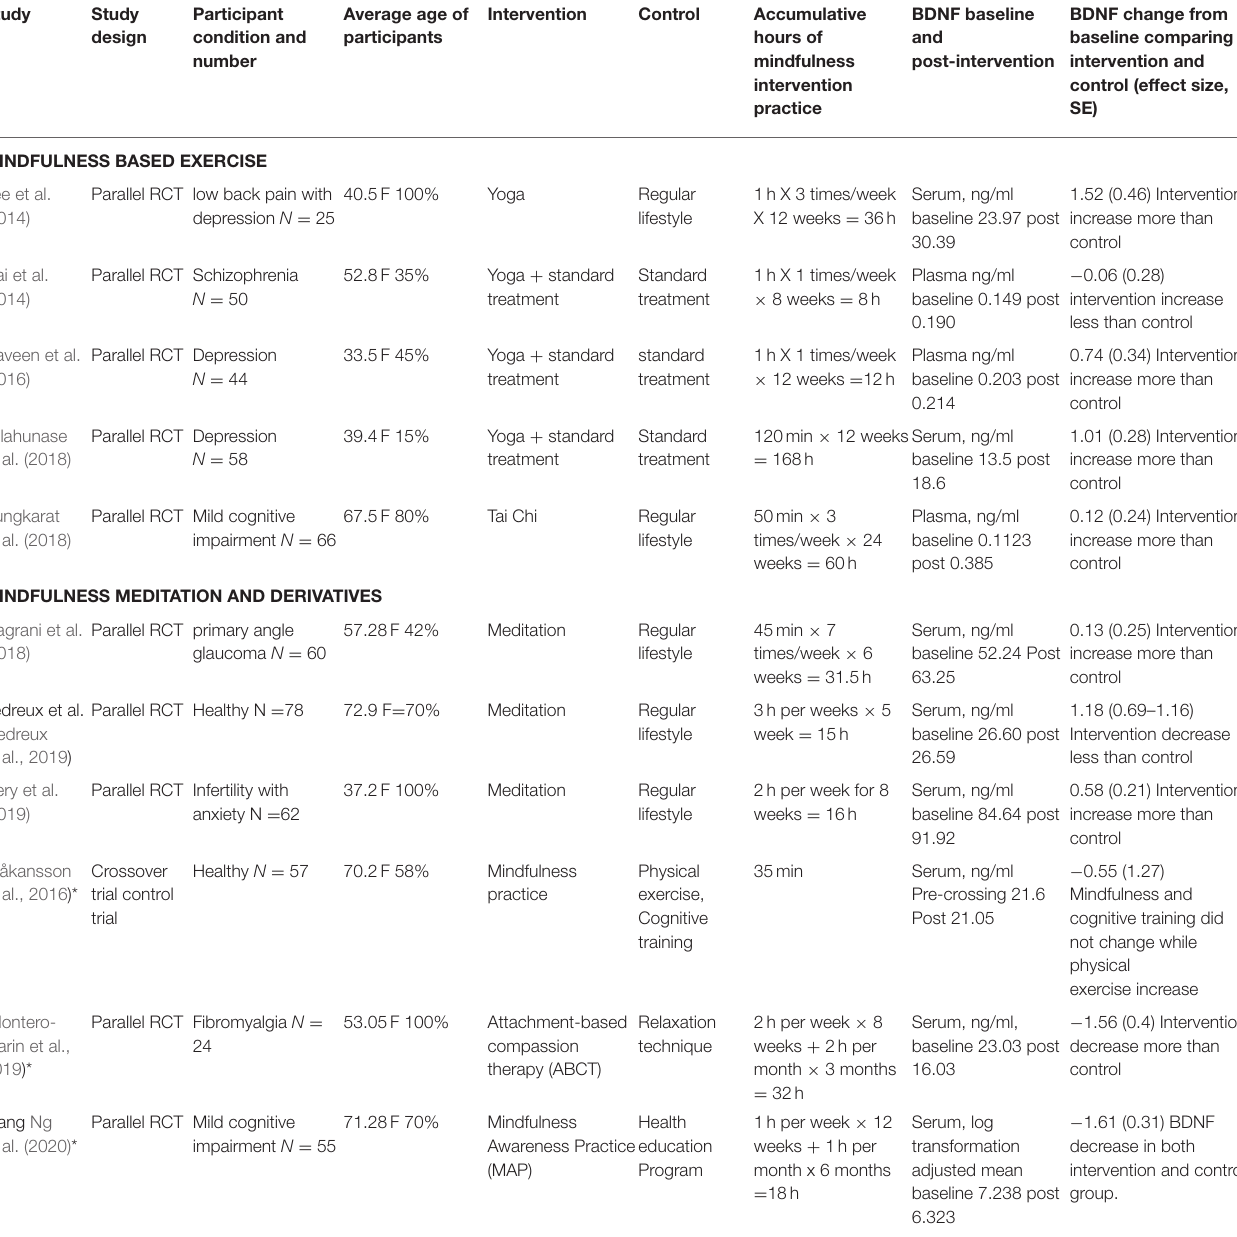
TABLE 1 | The included studies for systematic review ( * Not included studies in the meta-analysis).